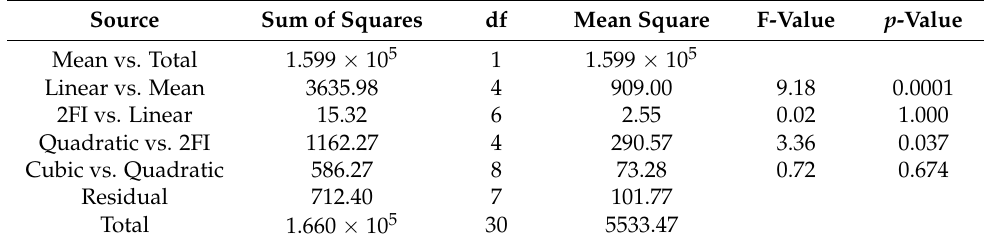
Table 4. Model prediction for analysing based on the experimental data for biodiesel production.